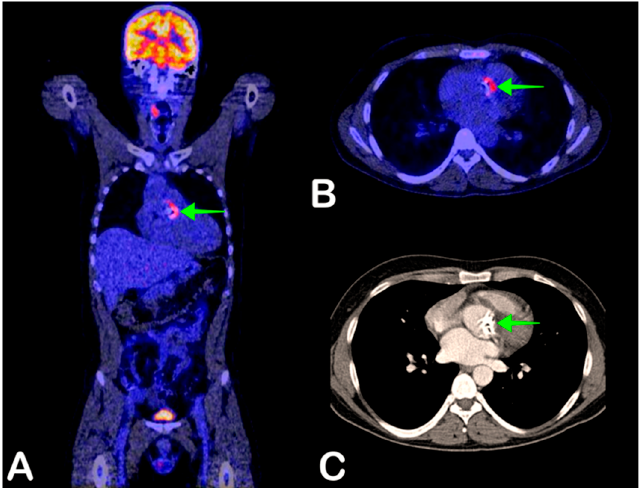
Figure 3. A 39-year-old man presented with general malaise for one week, fever of 41 degrees Celsius, and petechiae. Blood cultures were positive for Streptococcus pneumoniae . One year earlier, his native aortic valve was replaced with a mechanical valve. Endocarditis was strongly suspected, but transthoracic and transesophageal ultrasound did not prove valvular vegetations or other signs of infection. Fused coronal and axial FDG-PET/CT showed FDG avidity of the prosthetic aortic valve suggestive of infection ( A and B , green arrow). No other infection foci were found. The aortic valve is also shown on full-dose thoracic CT ( C , green arrow), without any anatomical signs of infection. The aortic valve was surgically replaced after which the patient recovered.